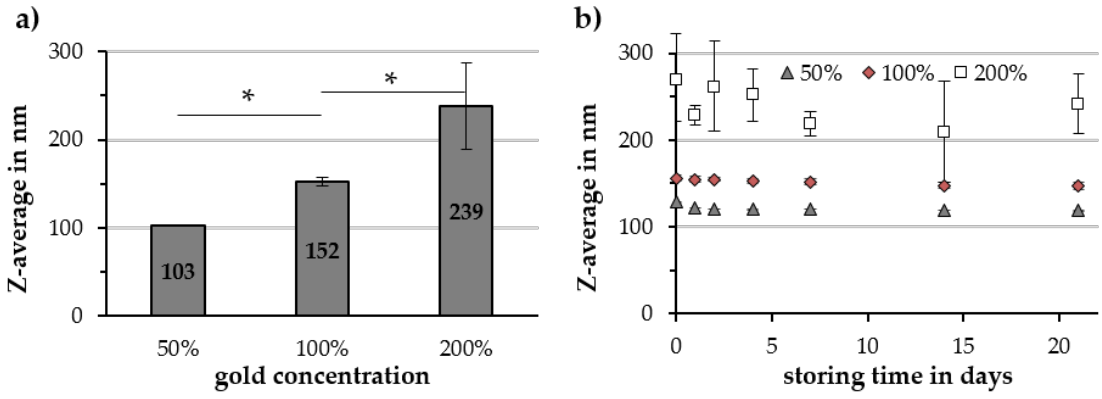
Figure 7. Influence of the gold concentration of Cit-Au-SPIONs on ( a ) the Z-average and ( b ) the particle stability during 21 days of storage in a fridge. Statistically significant changes are marked with * for p < 0.05.